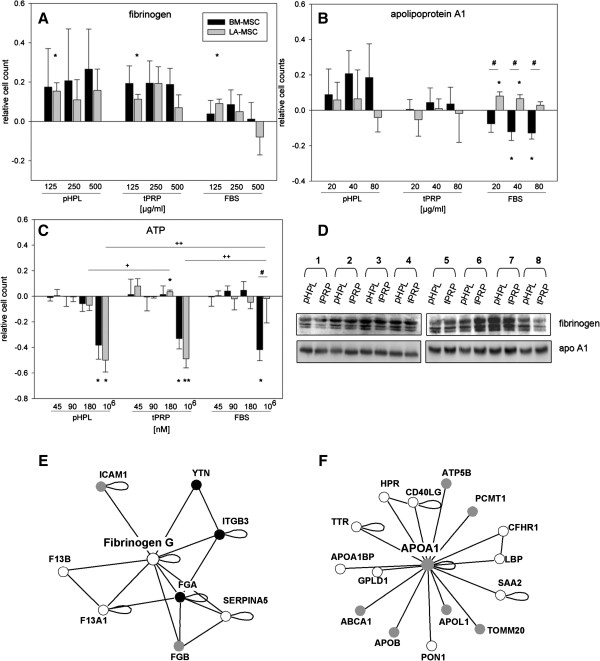
Influence of identified proteins and ATP on MSC proliferation. (A-C) MSC were seeded in 5% pHPL, tPRP and FBS, respectively, and stimulated for 3 days with: (A) 125, 250 and 500 μg/ml fibrinogen, (B) 20, 40 and 80 μg/ml apoA1 and (C) 45, 90, 180, and 106 nM ATP. Cell counts were measured using the CellTiter-Glo assay and then normalized to the unstimulated control to calculate relative cell count values. Symbols indicate statistically significant diffences between: * stimulation; + supplements; # MSC sources; (one symbol p < 0.05; two symbols p < 0.01). (D) Western blot verification of differentially expressed proteins, fibrinogen and apo-A1 in pHPL and tPRP (2.5 μg protein/lane, eight different batches, respectively). Functional platelet interaction network analysis for fibinogen gamma (E) and apolipoprotein A1 (F) was performed using PlateletWeb and subnet extraction according to Boyanova et al. [20] (white circles denote platelet proteins with no detected phosphorylation sites; black circles denote platelet proteins with phosphorylation sites detected in platelets; grey circles denote platelet proteins with phosphorylation sites detected in human cells).